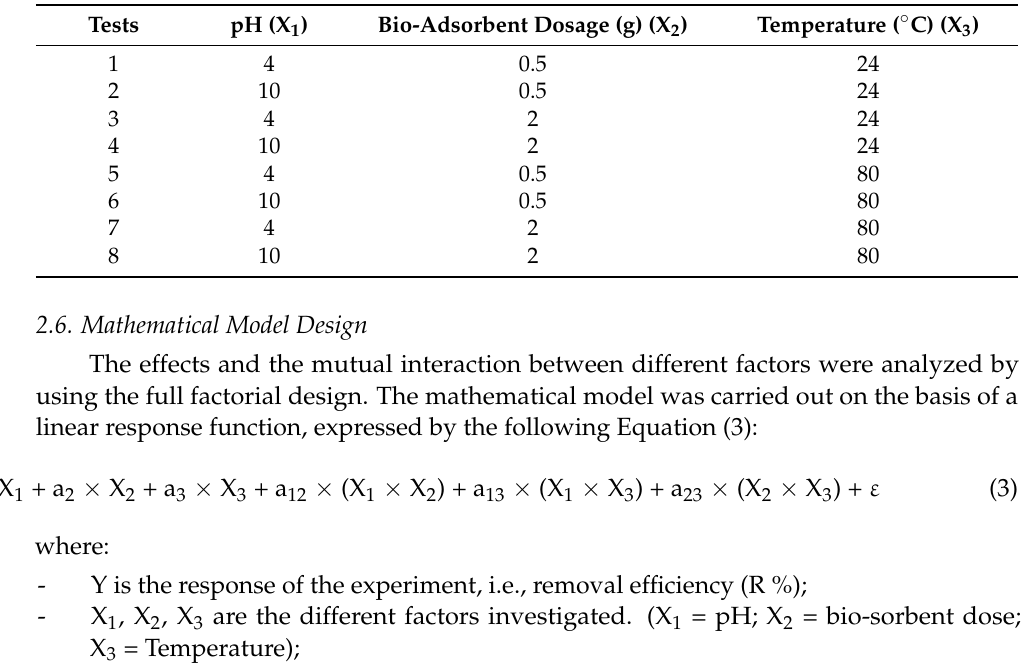
Table 2. Values of factors for each